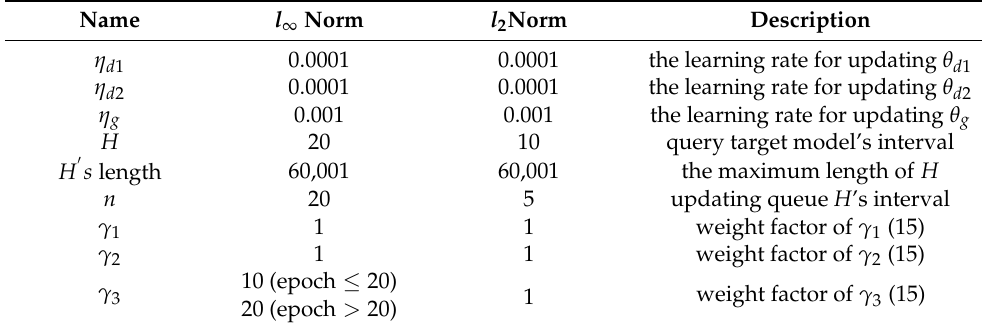
Table 2. Experimental parameter setting of MNIST.